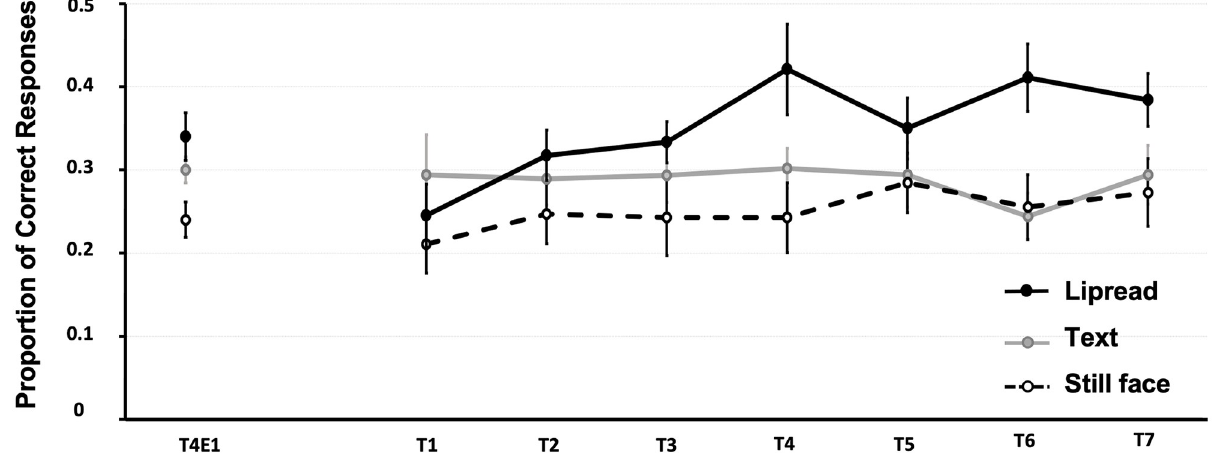
Fig 4. Proportion of correct responses in Experiment 2. Grand average proportion of correct responses during the follow-up auditory-only test blocks for each type of training conditions (lipread speech, text, still face). Data from the last test block from Experiment 1 (T4E1) is also included. Error bars represent one standard error of the mean.